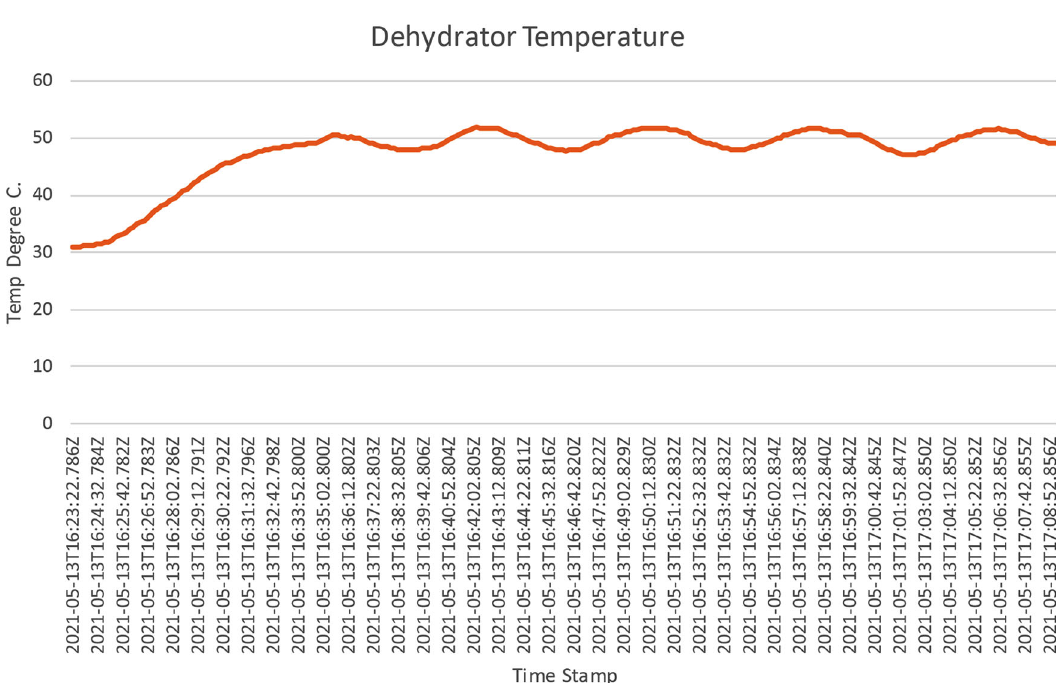
Figure 15. Chart of ResearchTest operation in Microsoft Office 365 Excel. The chart shows temperature in ° C as a function of time for the Operational Test on PID Temperature